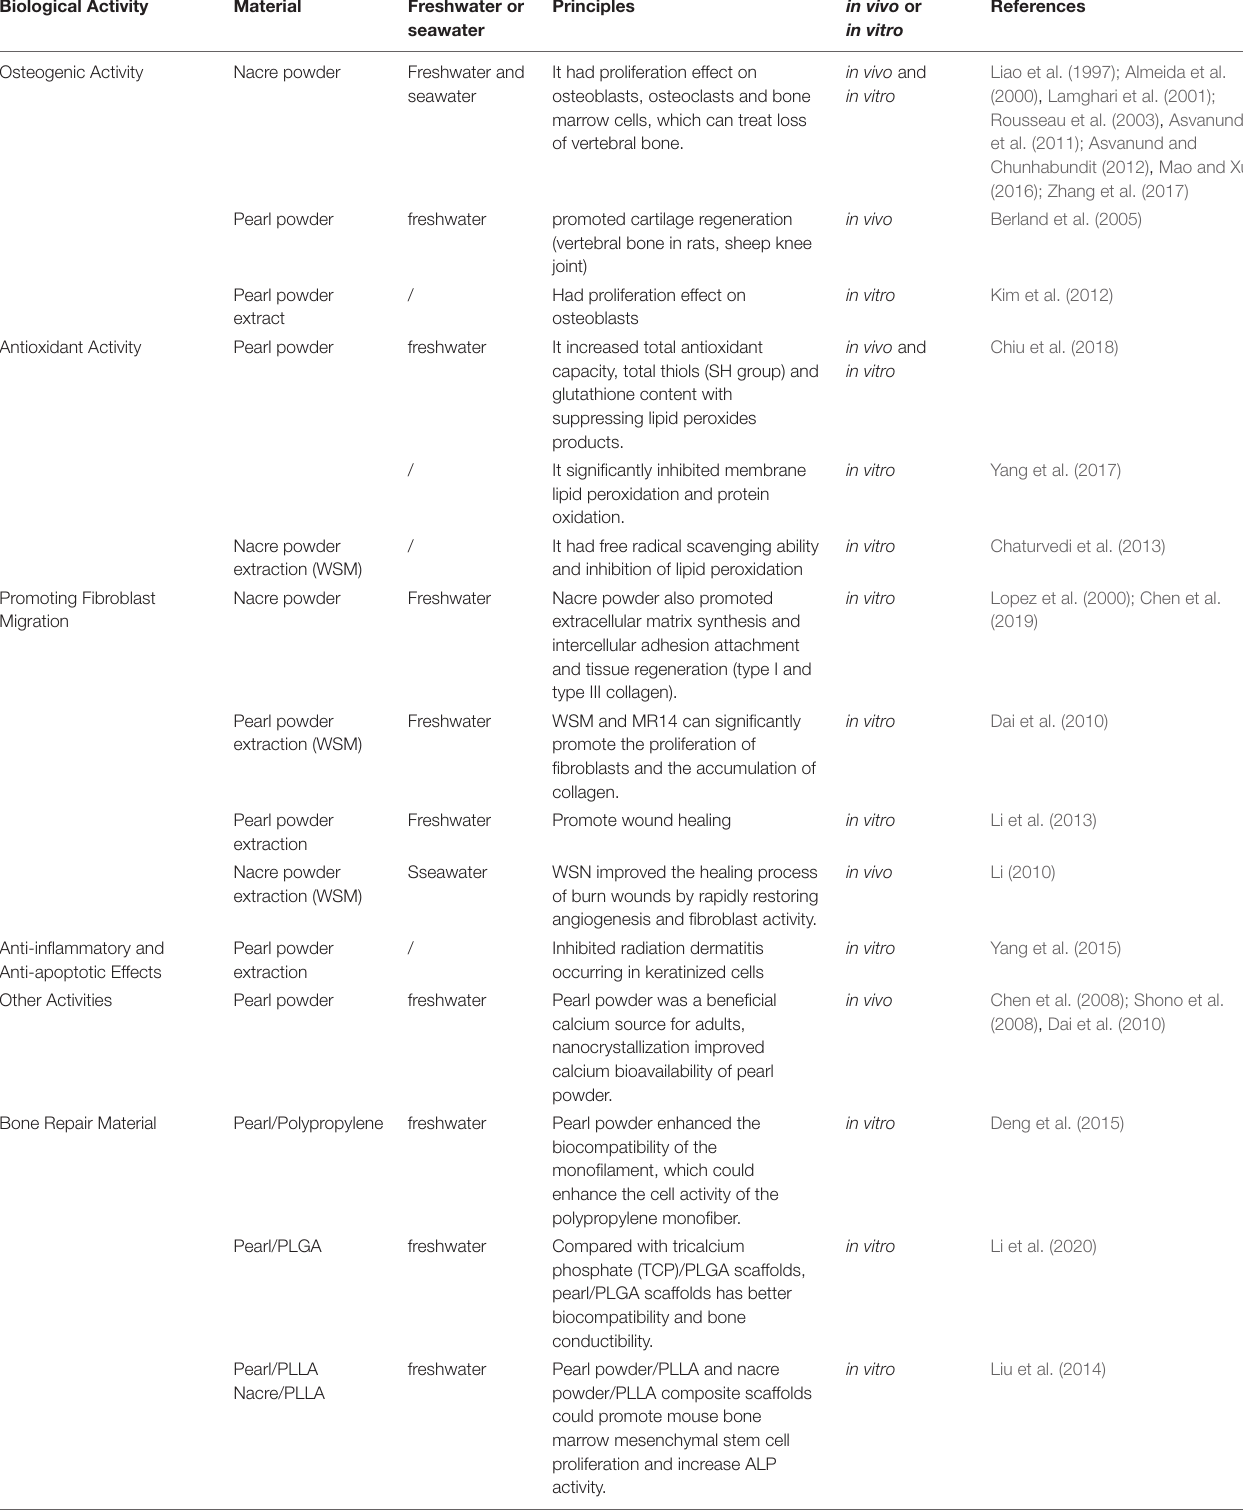
TABLE 4 | Summary of the effect of nacre powder and extraction, pearl powder and